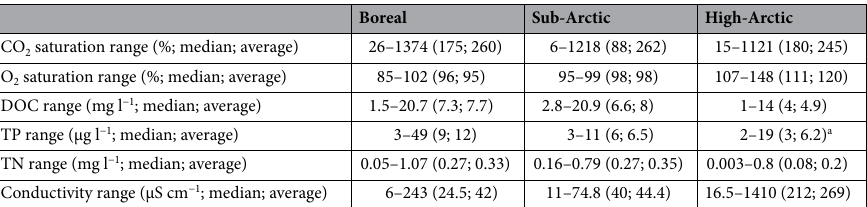
Table 1. Statistics of the lake chemistry variables used in the analyses. a 12 out of 22 lakes with concentrations below detection limit.